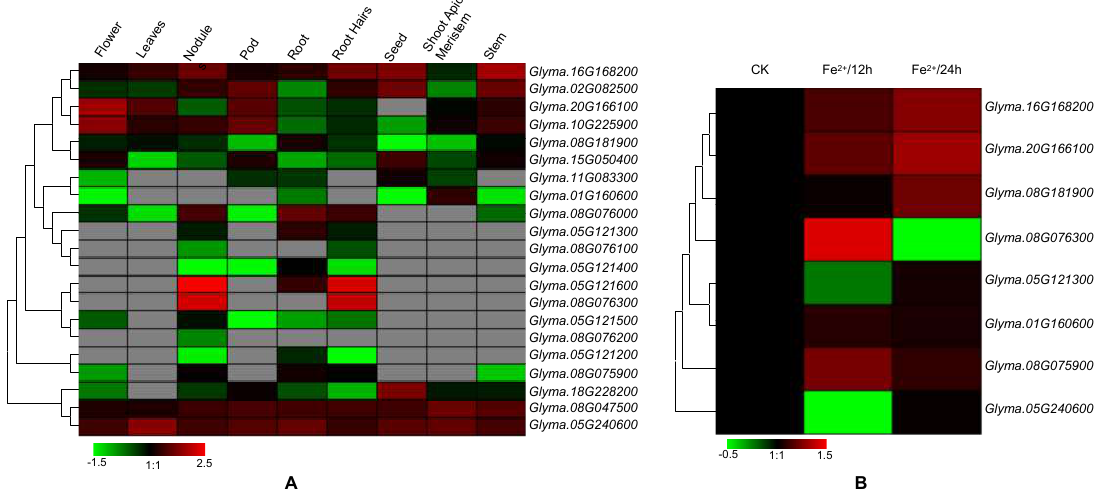
Figure 4. Expression patterns of the VIT genes in soybean different developmental stages and under iron stress by RNA-seq data ( A ) and qRT-PCR (quantitative real time polymerase chain reaction) ( B ), respectively. Heat maps reflect the strength of relative